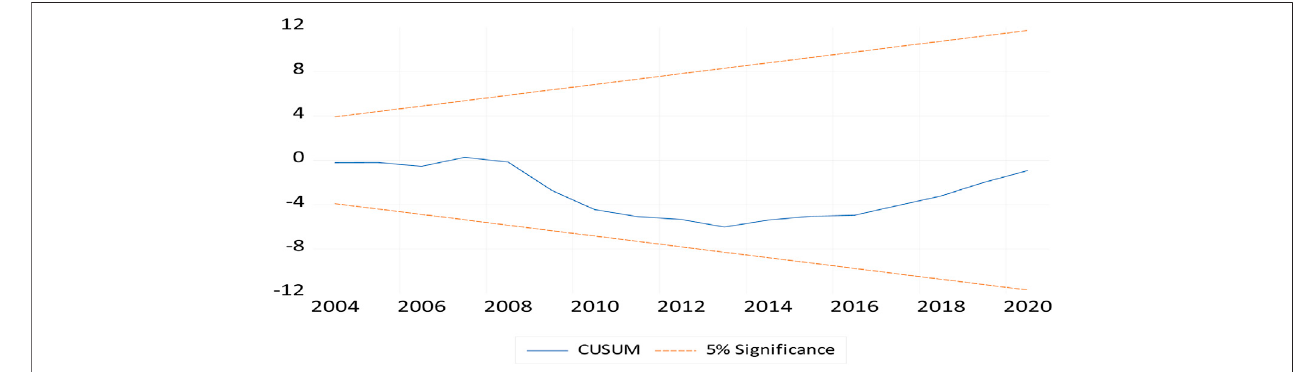
FIGURE 2 | Cumulative sum of recursive residuals. Source: EViews estimations.